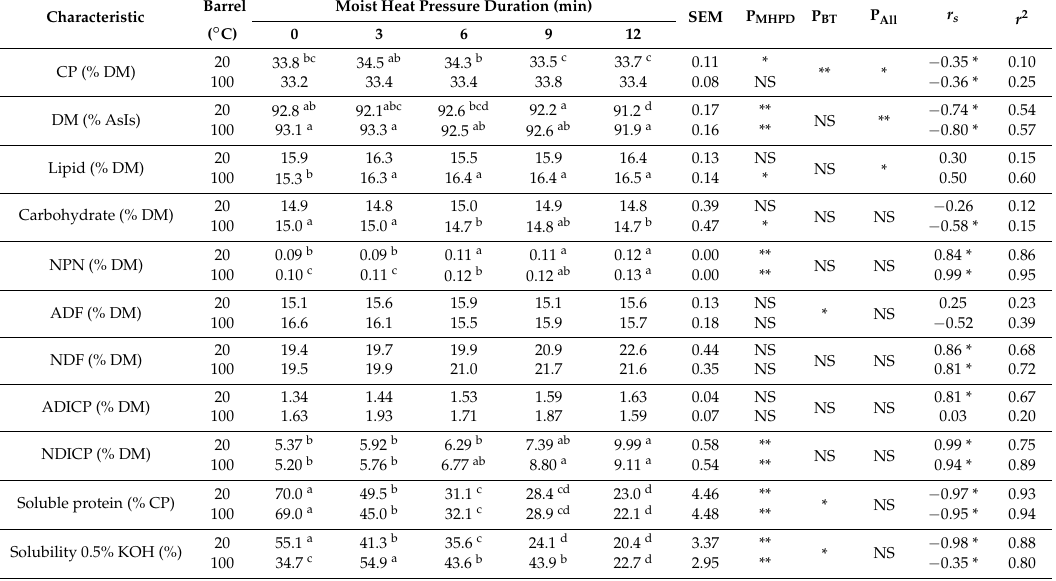
Table 1. General chemical and protein degradability characteristics of cold-pressed (20 ◦ C) and expeller (100 ◦ C) canola meals with moist heat pressure treatment for durations of 0, 3, 6, 9 or 12 min.